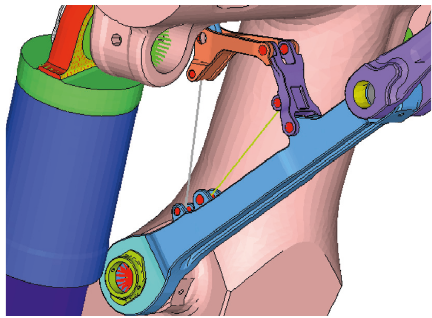
Figure 15: Secondary actuation system.